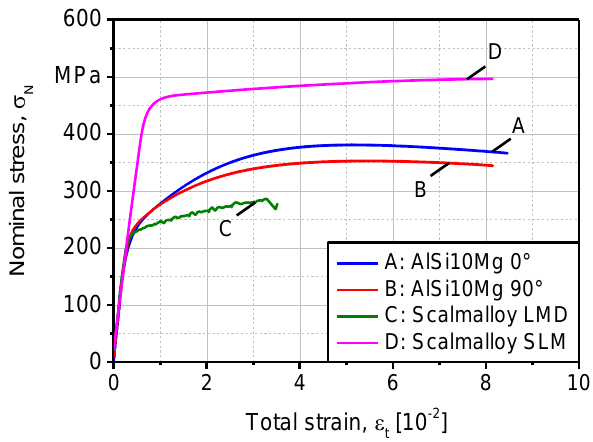
Figure 11. Quasi-static mechanical properties of batches A–D.